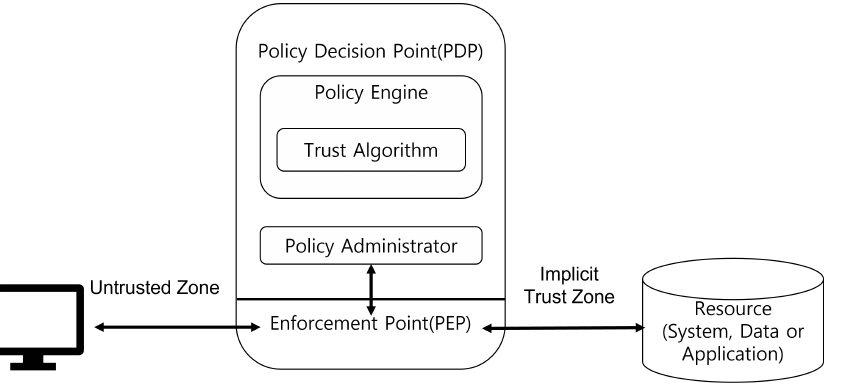
Figure 1. Zero Trust Access.